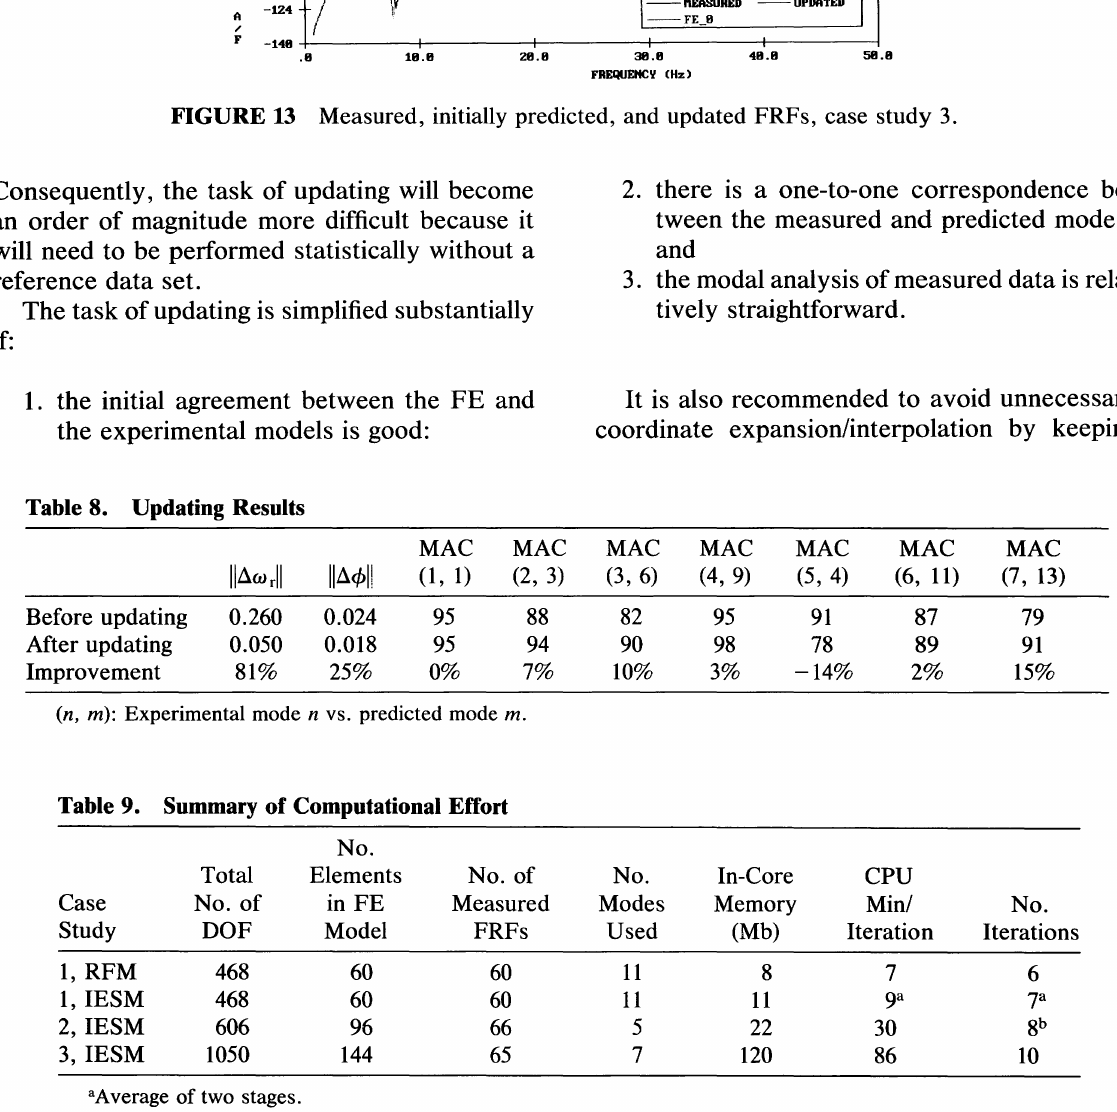
FIGURE 12 Measured and initially predicted FRFs, case study 3.